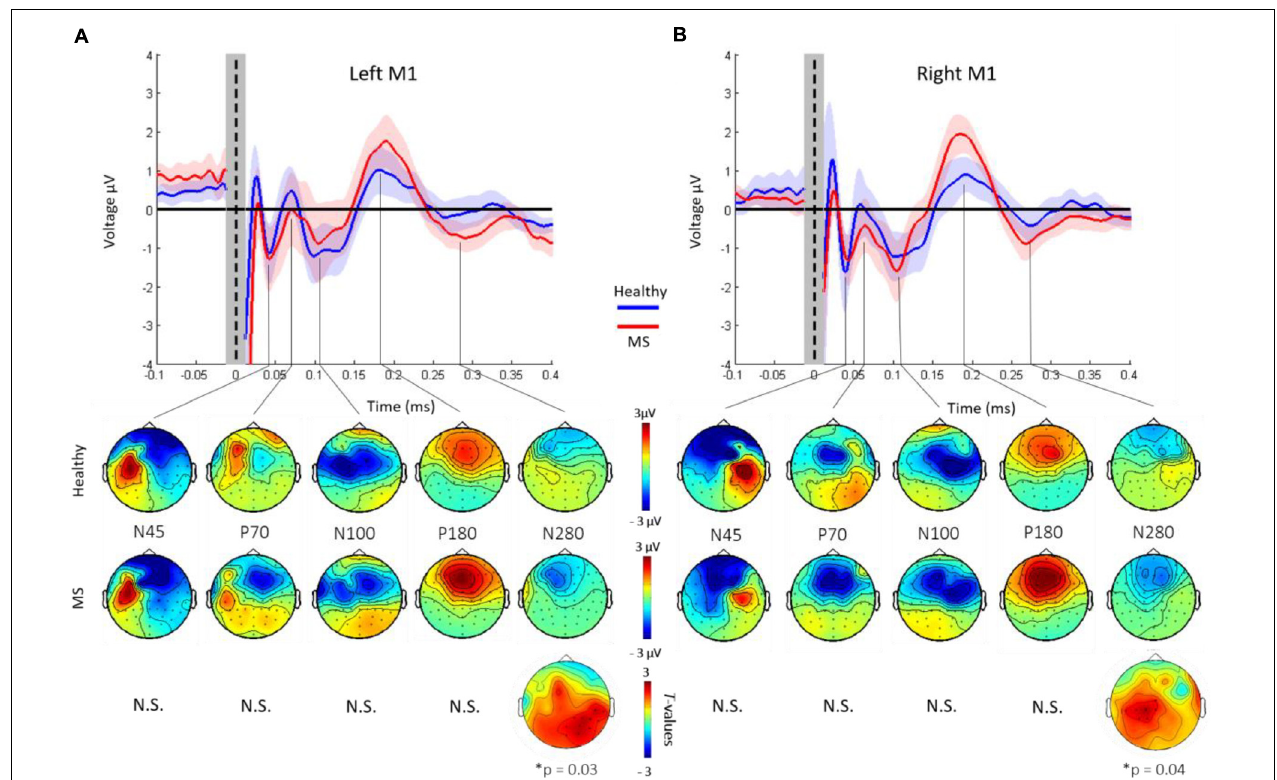
FIGURE 2 | Grand-average TEPs across all channels of healthy controls (blue) and MS patients. Shades represent ± 1 SEM. TEPs are shown for left (A) and right (B) M1 stimulation, respectively. Vertical dashed line, time of TMS. The shaded gray bar represents the part of the EEG trace ( ± 10 ms) that was linearly interpolated to remove the TMS-induced artifact. TEP components are labeled according to their polarity and approximate latency. Lower panel shows topographical distributions of surface voltages ( µ V) for the most pronounced TEP components (N45, P70, N100, P180, and N280), for healthy controls (upper row) and MS patients (lower row), respectively. The N280 amplitude was significantly larger in the MS cohort compared to HCs ( p < 0.05). Bottom row: t -statistic maps of the TEP amplitude differences (HC minus MS). Black dots indicate significant channels, predominantly in the non-stimulated